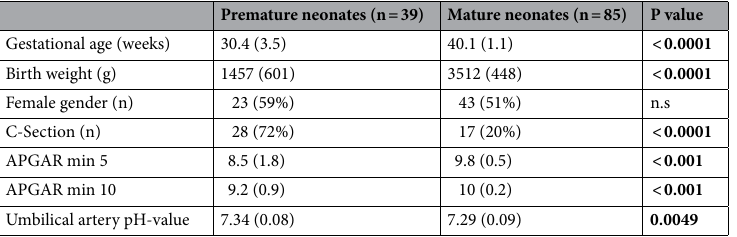
Table 1. Patient characteristics at birth. Data are presented as mean (SD) or as number (%) as appropriate. Statistical analysis was performed with t test or Mann–Whitney U test (numerical data) and Fisher’s exact test (categorical data). Statistically significant results are marked in bold.